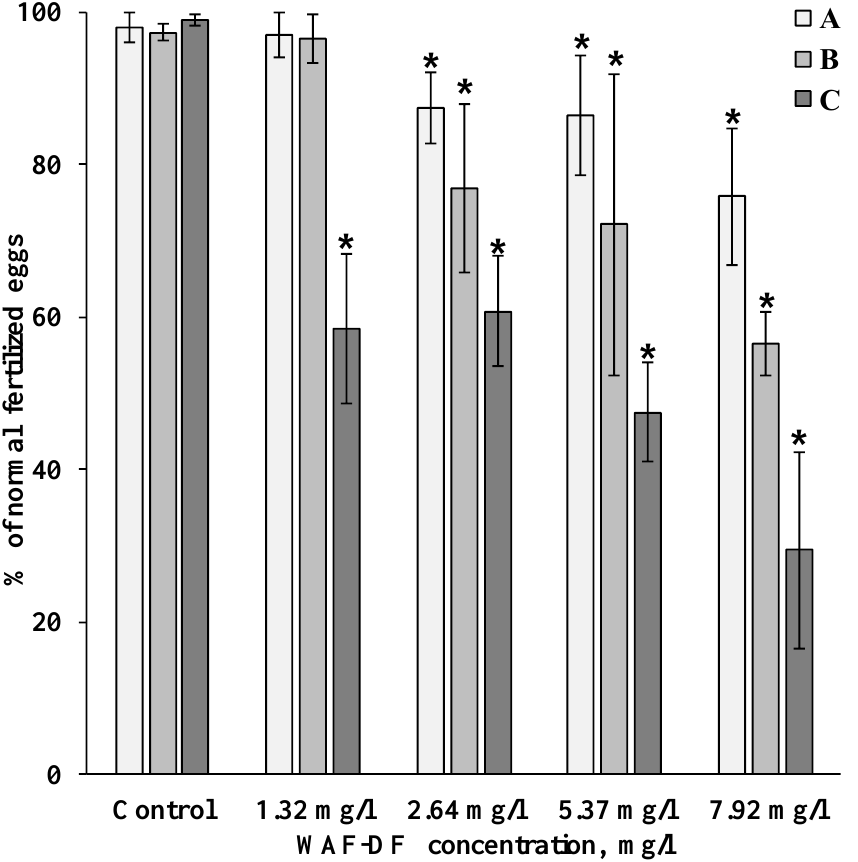
Figure 3. Effect of WAF-DF exposure of different kinds of germ cells on the fertilization of the sand dollar S. mirabilis (A—sperm were exposed to WAF-DF; B—eggs were exposed to WAF-DF; and C—both types of gametes were exposed to WAF-DF (mean ± standard deviation). * Difference from the control is significant ( p < 0.05).